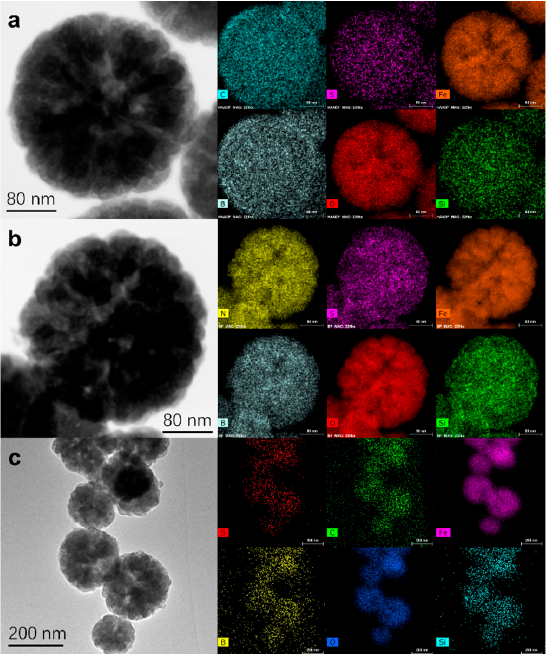
Figure 3. STEM elemental mapping images of the phenylboronic-acid-modified magnetic nanoparticles Fe 3 O 4 @MPTES@VPBA ( a ), Fe 3 O 4 @MPTES@AAPBA ( b ) and Fe 3 O 4 @MPS@MPBA ( c ).